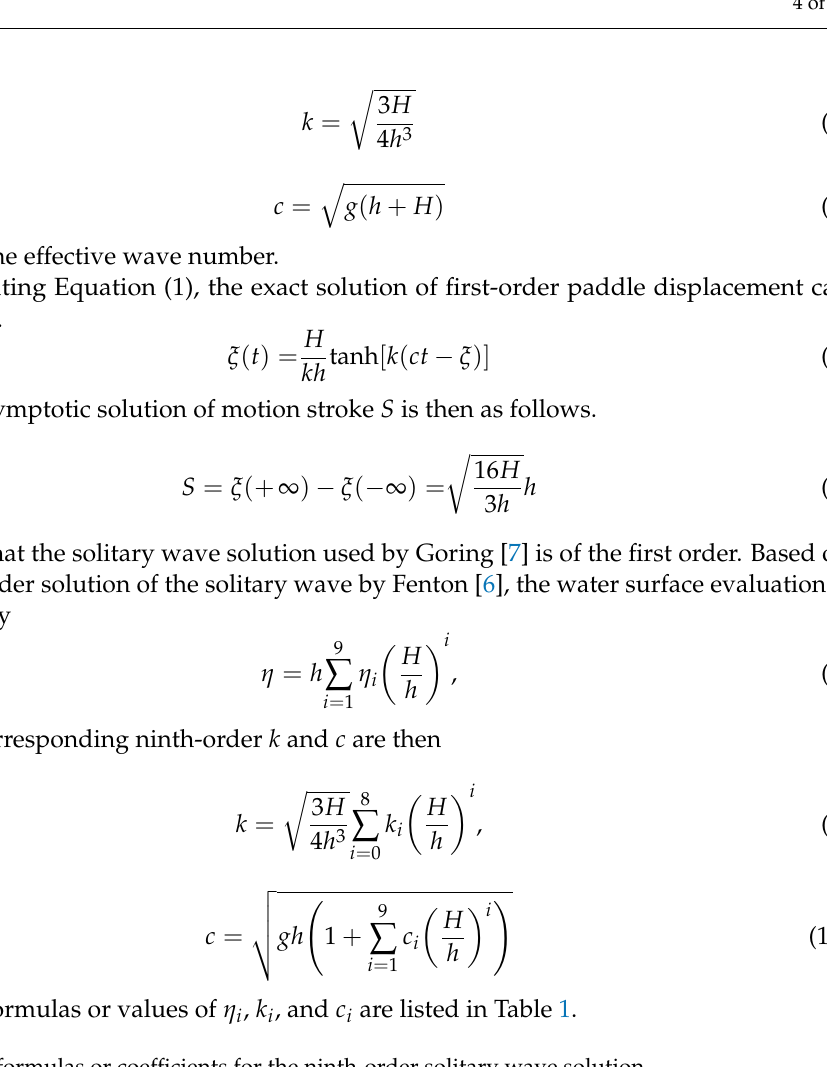
Table 1. The formulas or coefficients for the ninth-order solitary wave